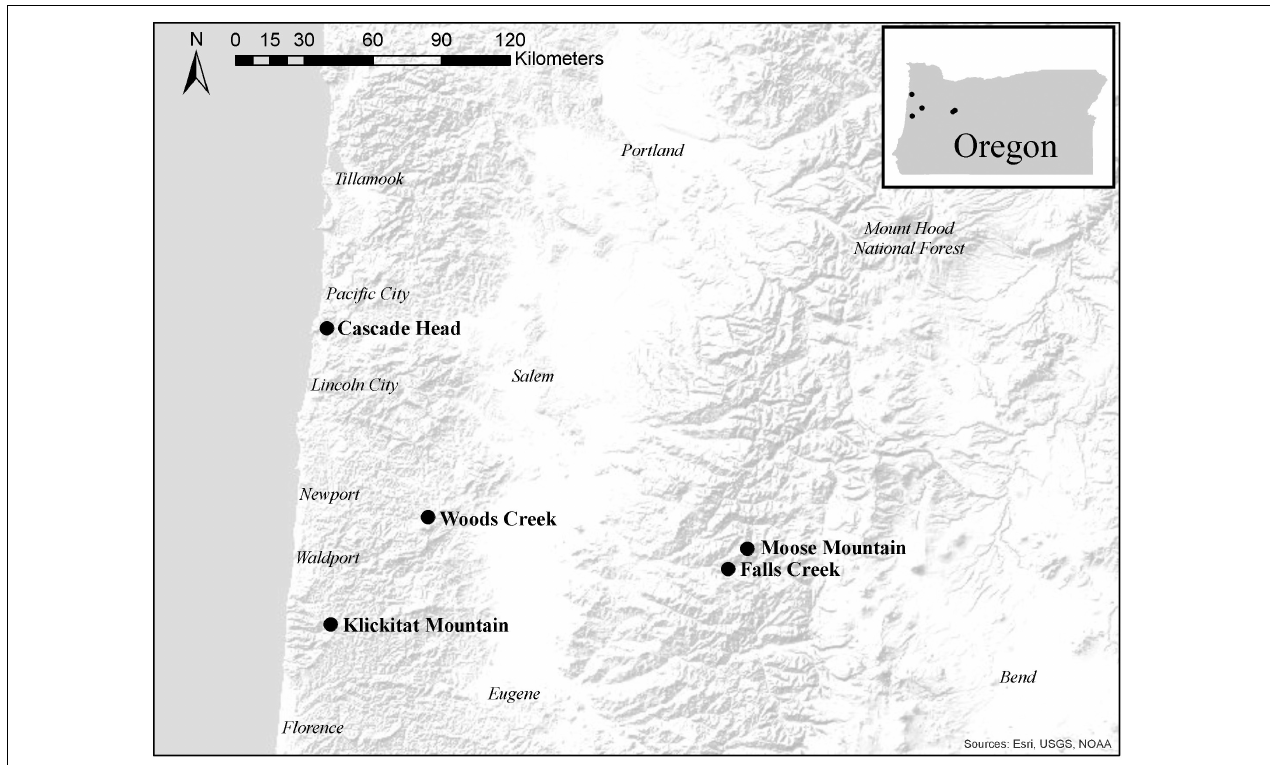
FIGURE 2 | Map of study sites in the Oregon Coast Range and western Cascade Mountains of western Oregon, United States. Cascade Head, Falls Creek, and Moose Mountain are in the long-term ecological monitoring plot (LTEM) system, and Klickitat Mountain and Woods Creek are not part of the LTEM system. Cascade Head, Klickitat Mountain, and Woods Creek are in the Siuslaw National Forest. Falls Creek and Moose Mountain are in the Willamette National